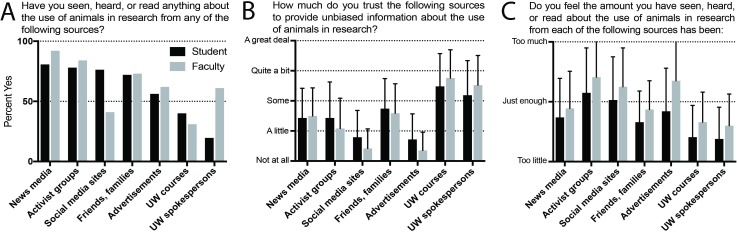
Sources of information.(A) Prevalence of sources of information about animals in research. (B) Trust in sources to provide unbiased information. (C) Sufficiency of information from each source. For B and C, data is shown as mean ± standard deviation.